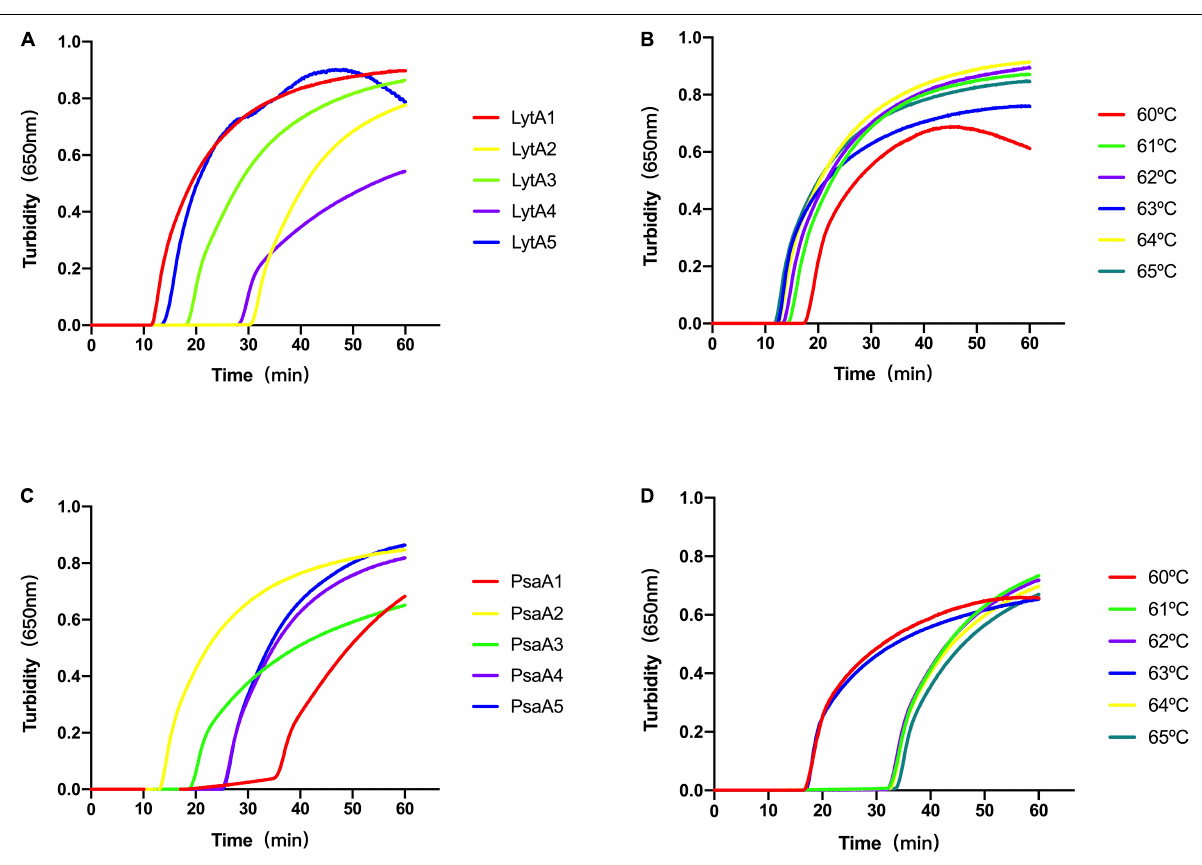
FIGURE 2 | The most suitable primers and reaction temperature used for loop-mediated isothermal amplification (LAMP) analysis. (A) The most suitable primer pair for LAMP analysis to amplify the lytA gene. (B) The optimal reaction temperature for LAMP analysis using primer LytA-1. (C) The most suitable primer set for LAMP analysis to amplify the psaA gene. (D) The optimal reaction temperature for LAMP determination using primer PsaA-2. The reaction volume is 25 µ L, contains 2 µ L of DNA template, and the template concentration was 2 ng/ µ